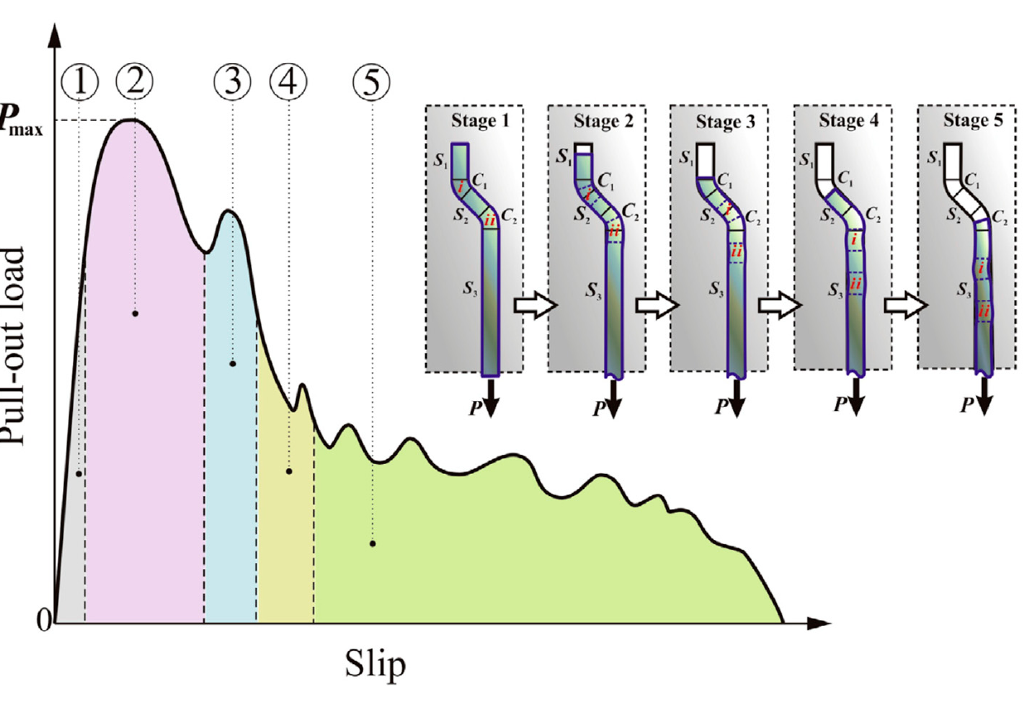
Figure 12. The pull-out performance of a hooked-end steel fibre embedded in concrete; these pull-out processes can be divided into several stages and each stage has been marked out with circles in left curves: Stage 1: elastic and partial debonding stage; Stage 2: the first plastic deformation stage; Stage 3: the second plastic deformation stage; Stage 4: deformation-sliding hybrid stage. Stage 5: frictional sliding stage [11].